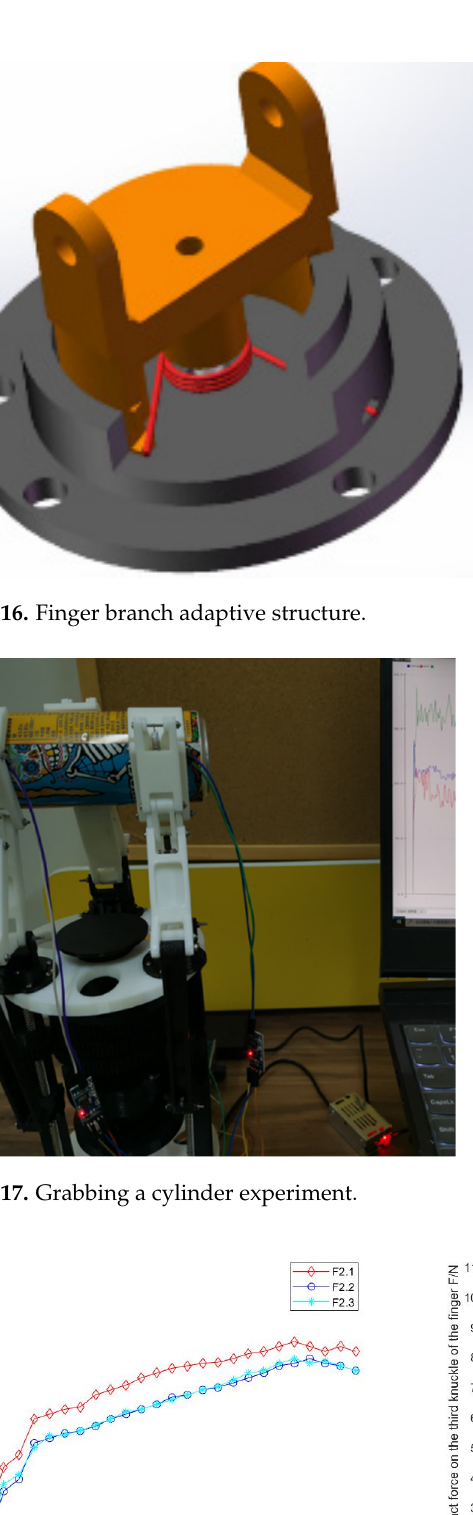
17 of 20 Figure 15. Underactuated manipulator.